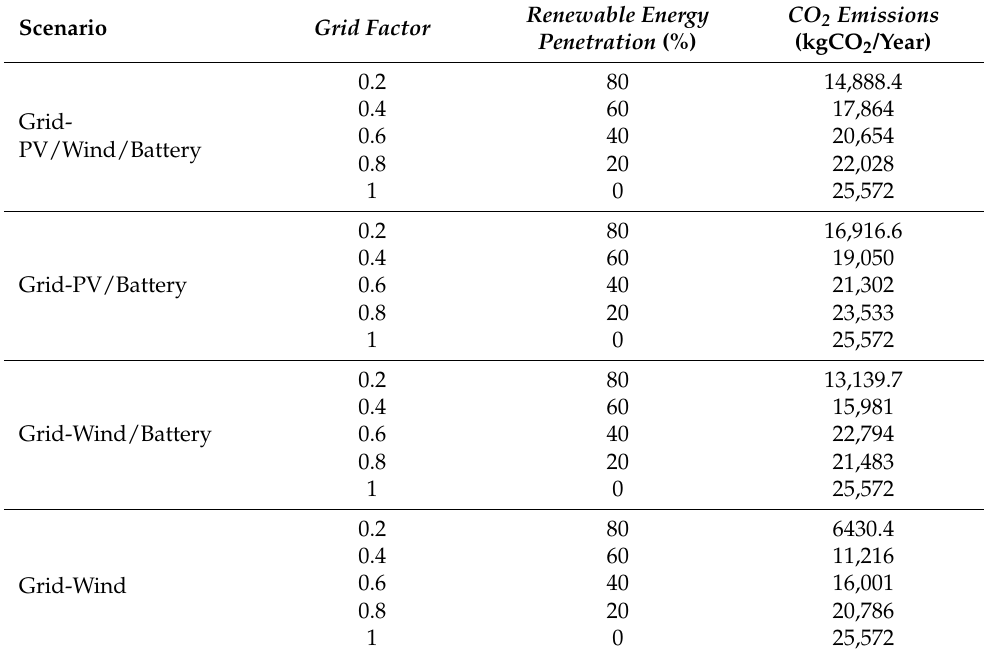
Table 13. Influence of the renewable energy penetration rate on the system’s carbon dioxide emissions. Renewable Scenario Grid Factor